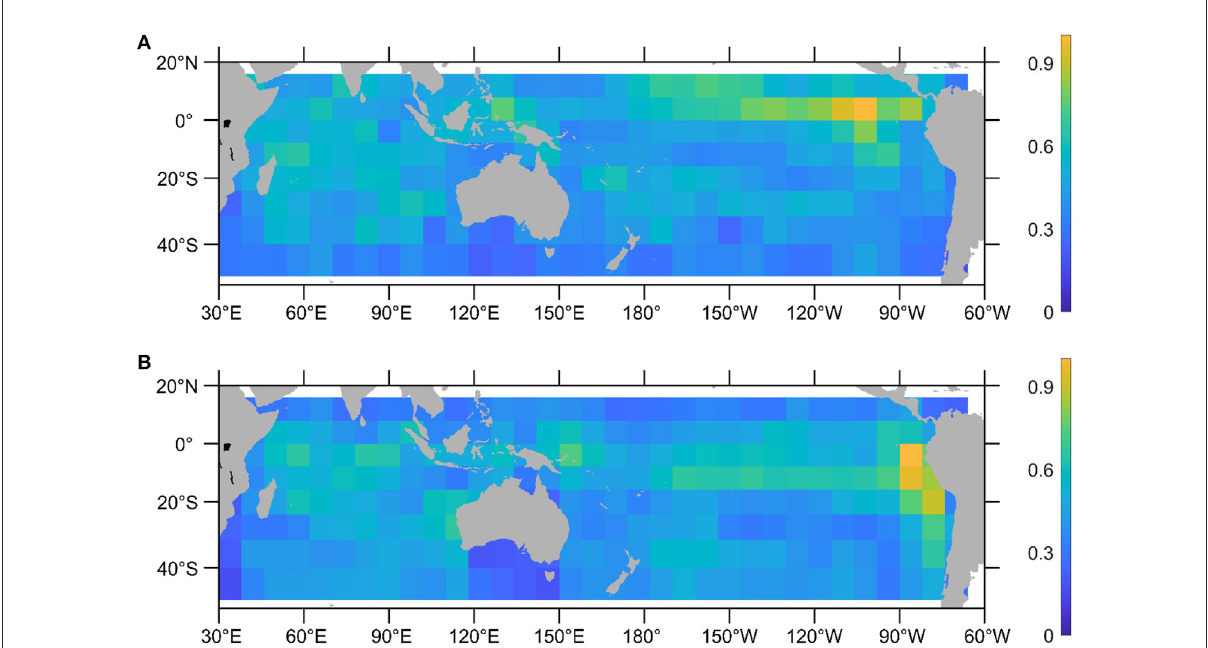
FIGURE4 Standard deviations of the CNN model activation maps during 1982–2020: (A) using May-June-July inputs to forecast September EIOD SST anomalies, and (B) using June-July to August inputs to forecast October EIOD SST anomalies. The standard deviations are normalized with a maximum value of